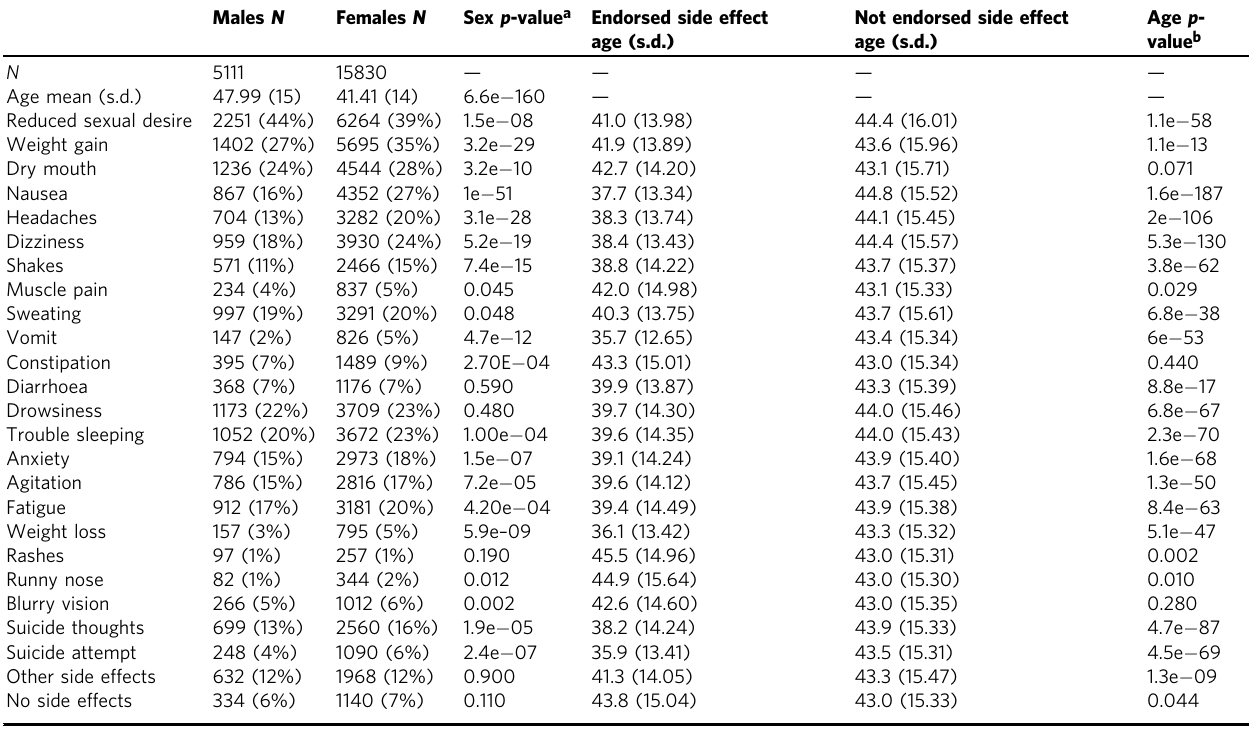
Table 1 AGDS demographics and side effect prevalence across medications. Males N Females N Sex p -value a Endorsed side effect